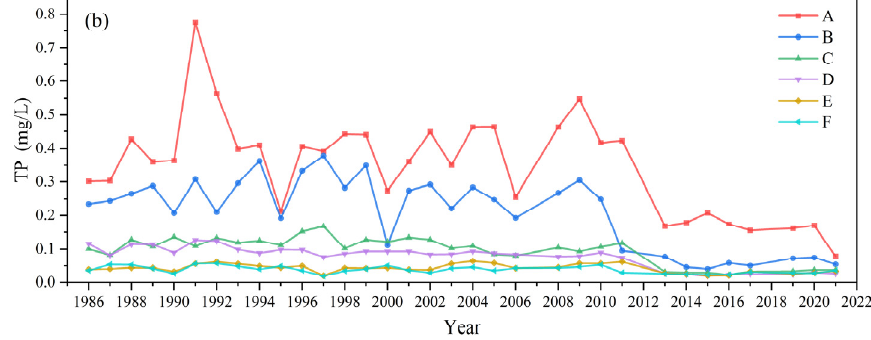
Figure 4. Inter-annual changes of ( a ) TN and ( b ) TP concentrations within the monitoring areas (A–F).